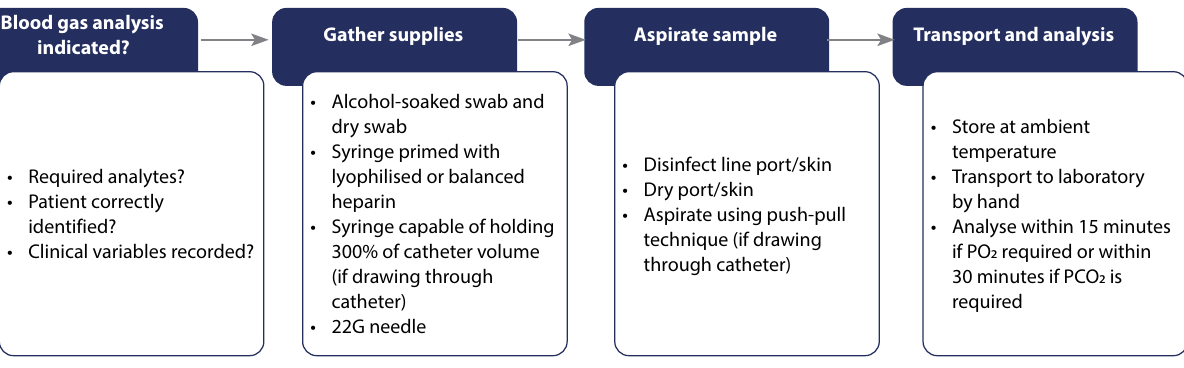
Figure 1: Suggested steps for obtaining and analysing a sample for acid-base analysis using blood gas analysis